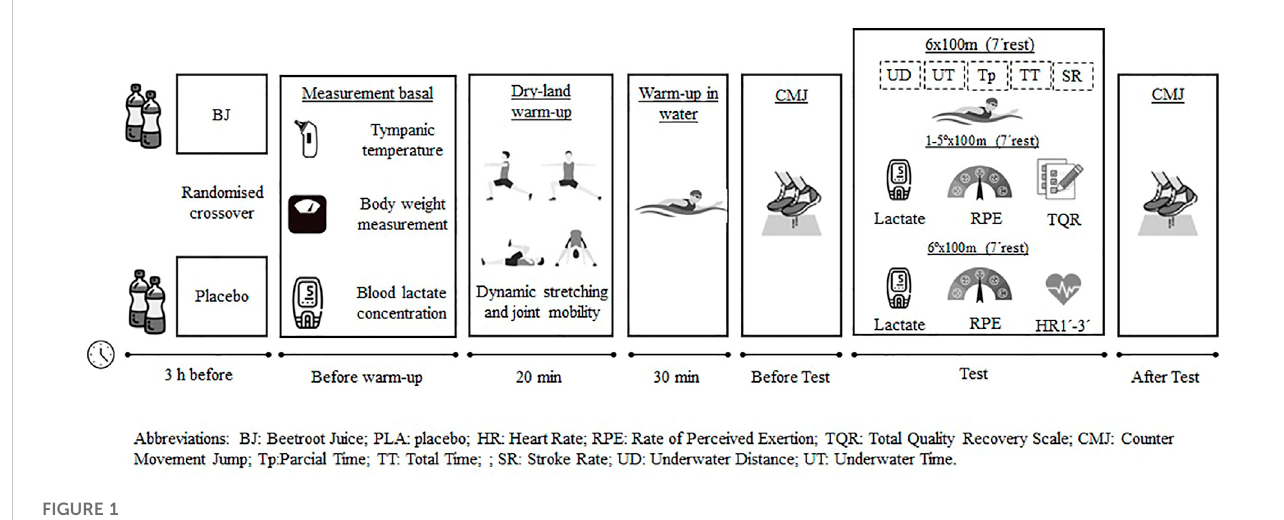
FIGURE 1 Diagram of the intervention